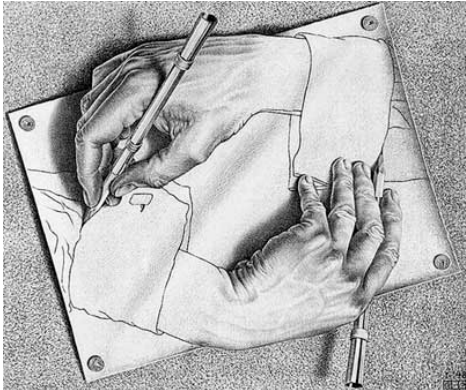
Figure 4. M. C. Escher, Drawing Hands ,